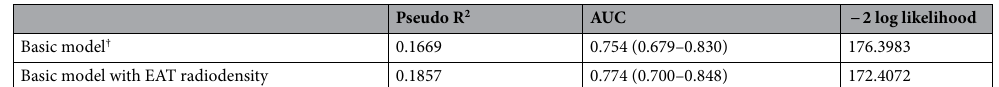
Table 3. Prognostic value of EAT radiodensity in the prediction of all-cause mortality in addition to a basic set of traditional risk factors in patients with ESRD. AUC area under the curve, BMI body mass index, CABG coronary artery bypass graft, CAD coronary artery disease, EAT epicardial adipose tissue, ESRD end-stage renal disease, hs-CRP high sensitivity C-reactive protein, LVEF left ventricular ejection fraction, PCI percutaneous coronary intervention. † Variables considered in the model were: age, sex, diabetes status, smoking status, PCI or CABG (Previous or subsequent), multi-vessel CAD on CT, statin use, duration of dialysis, serum calcium x phosphorus, serum albumin, serum hemoglobin, serum hs-CRP, and LVEF.